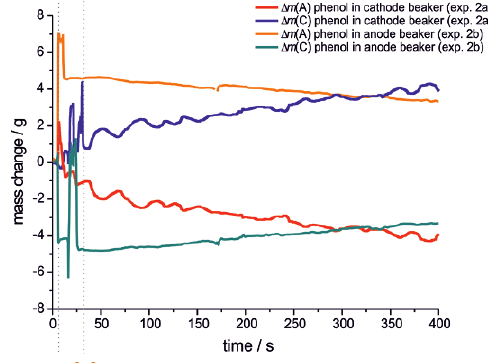
Figure 11. Comparison of the measured mass flow of one exemplary experiment of the series 2a with an extraordinary one of series 2b. The dotted grey lines mark the beaker separation time during which the read out of the balances is partly erroneous.